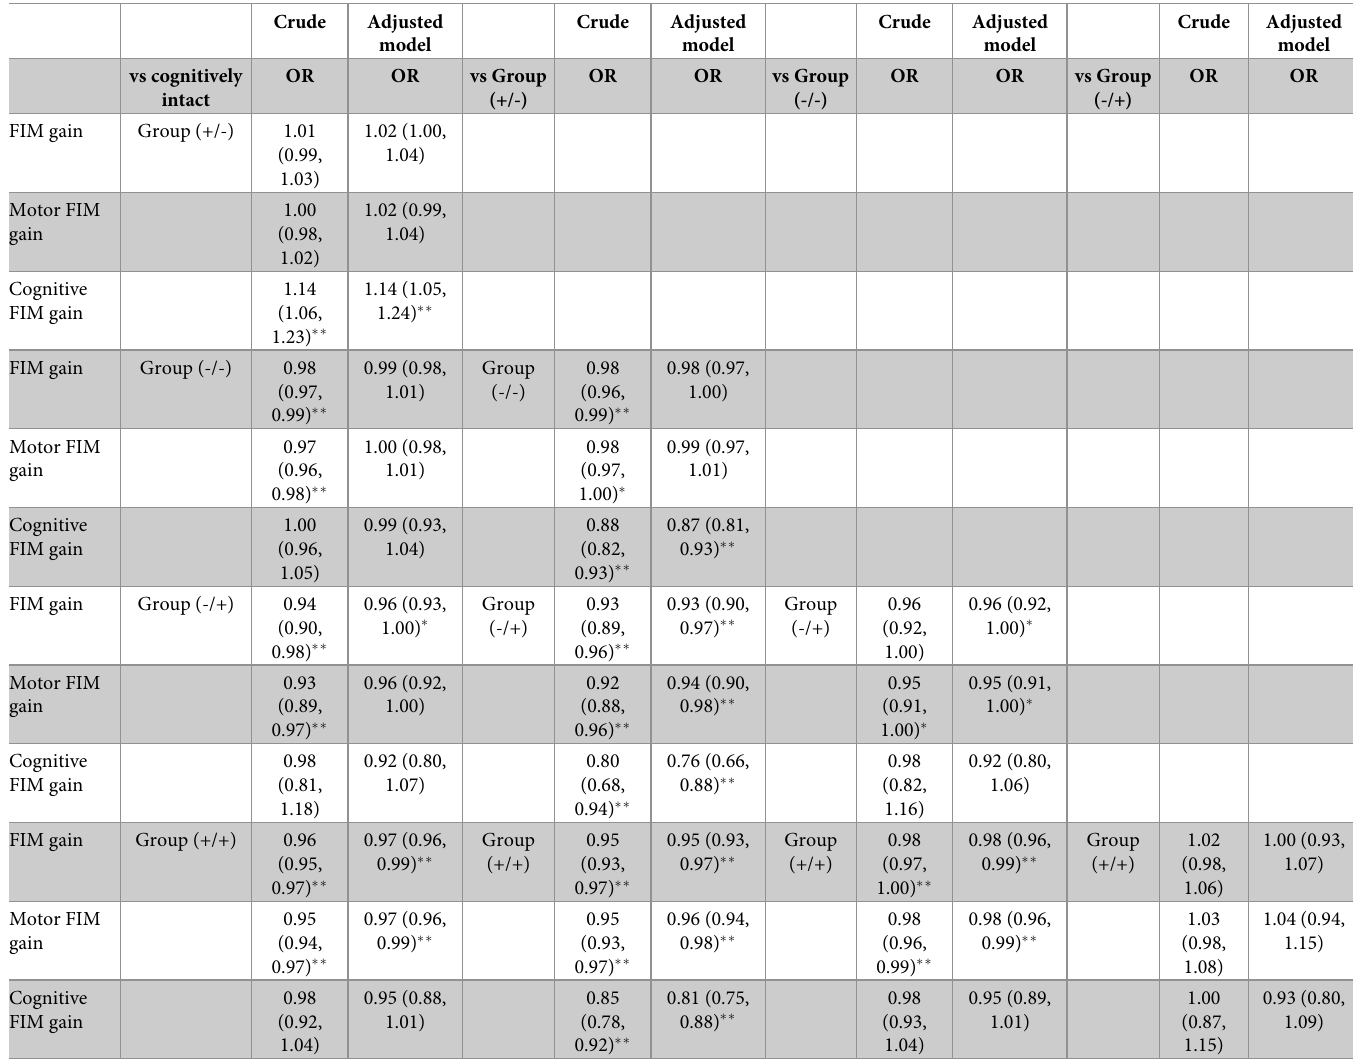
Table 4. Odds ratios (OR) (and 95% CIs) of rehabilitation outcomes obtained from multinomial logistic regression analyses among cognitively intact and cogni- tive-impaired groups with or without behavioral psychological symptoms of dementia. Crude Adjusted Crude Adjusted Crude Adjusted Crude Adjusted model model model model vs cognitively OR vs Group OR OR vs Group OR OR vs Group OR intact (+/-) (-/-) (-/+)